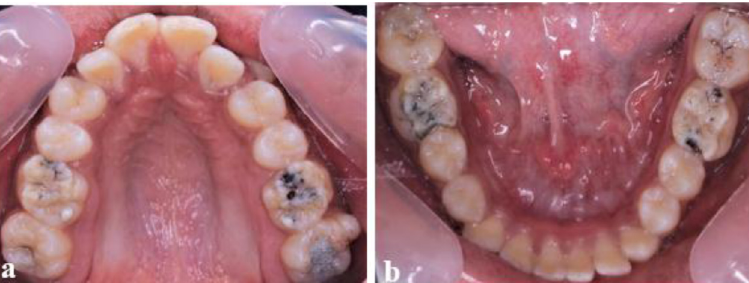
Fig. 1. Clinical images of the maxillary (a) and mandibular (b) arch of the patient demonstrating globular cusps of molars and impacted maxillary canines.